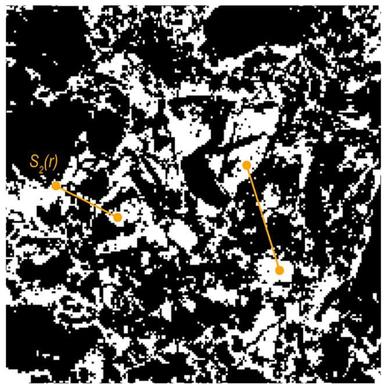
Schematic of the two-point correlation function for a binary microstructure.